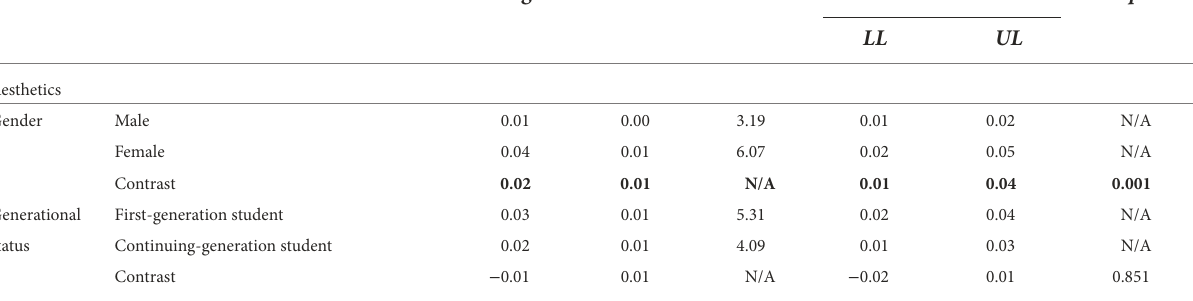
N/A, not applicable. Bold values are significant with p < 0.05.